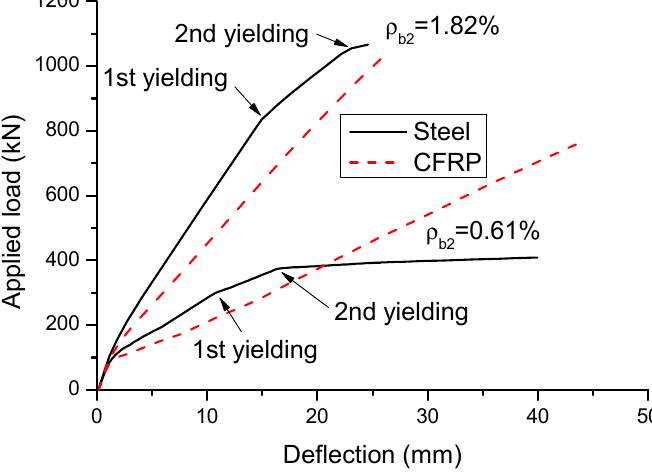
Figure 8. Load–deflection curves.